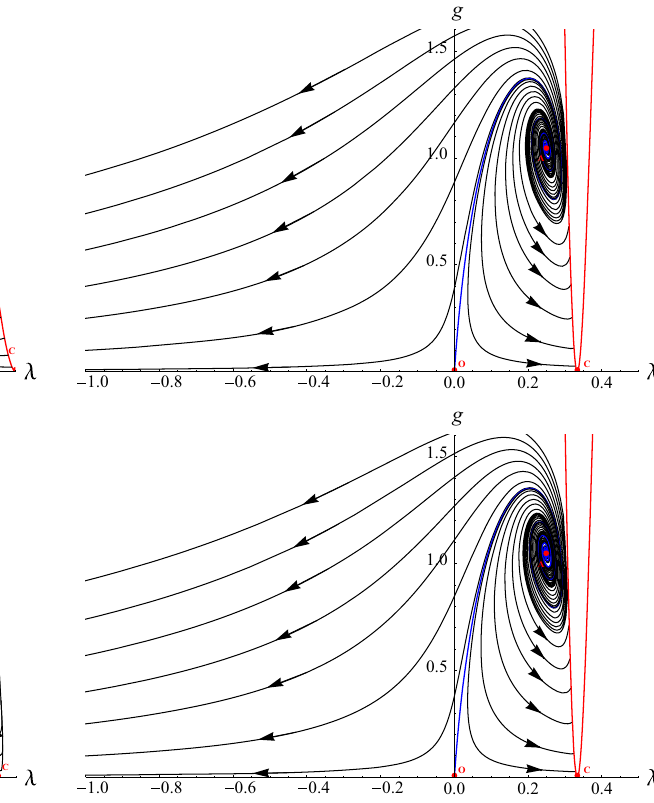
Fig. 3 Phase diagrams obtained from integrating the beta functions (29) for a Type I regulator ( r = 0, top line ) and a Type II 0 regulator ( r = 1, bottom line ). The first column gives the result for a linear split